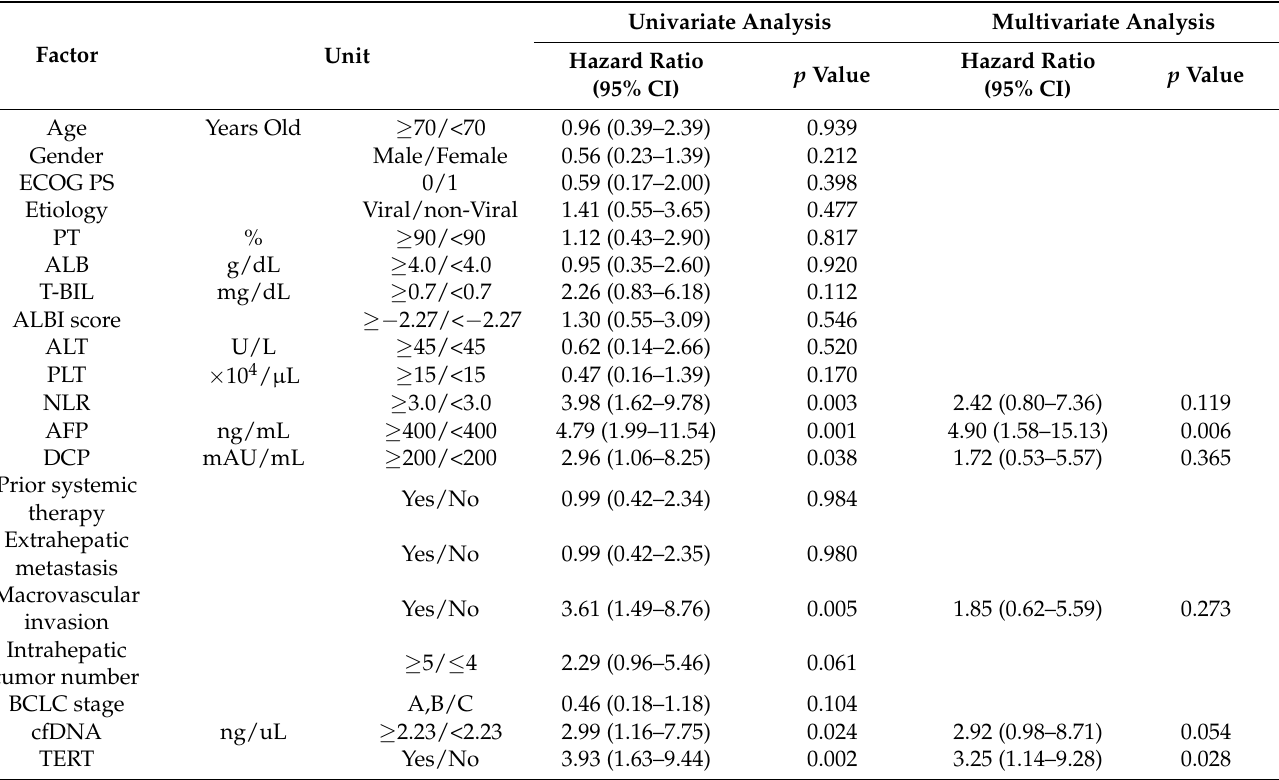
Table 2. Cox proportional hazards regression model for the prediction of overall